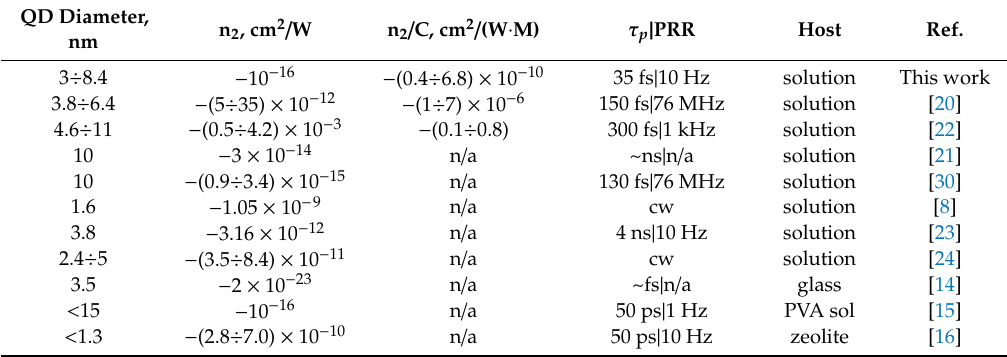
Table 1. Summary of PbS QD nonlinear refractions found in the literature. τ p —pulse duration. n 2 , cm 2 / QD diameter, nm